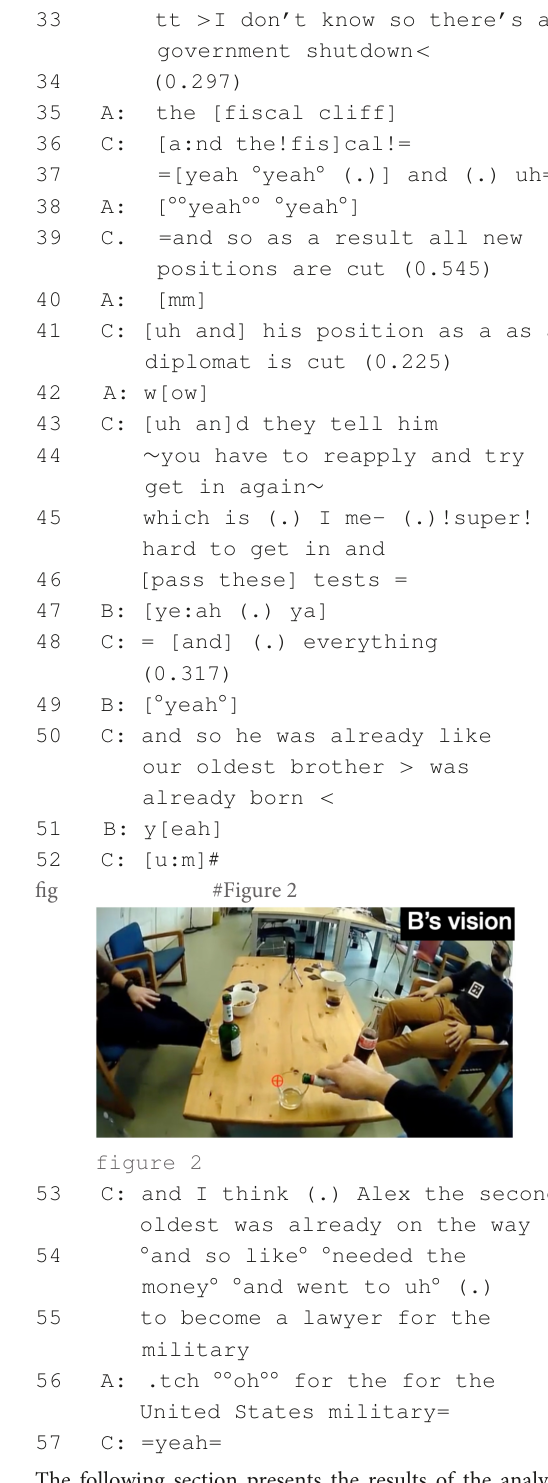
53 C: and I think (.) Alex the second oldest was already on the way 54 ◦ and so like ◦ ◦ needed the money ◦ ◦ and went to uh ◦ (.)